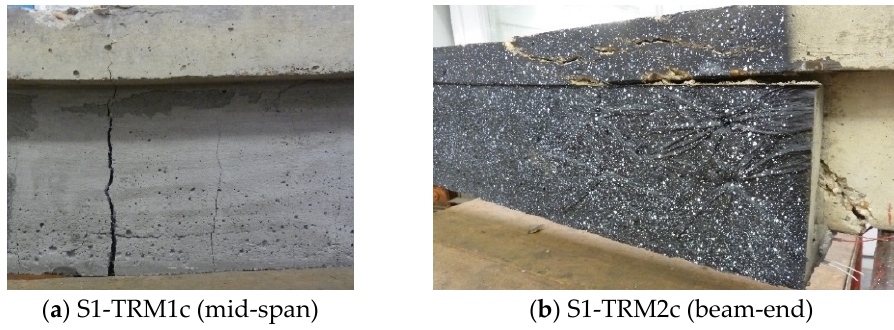
Figure 6. Observed failure in beams ( a ) S1-TRM1c and ( b ) S1-TRM2c. In series 2, with an increased a / d ratio, shear failure at the beam ends was observed for all three specimens, with shear cracking observed along the diagonal between the support and the load application (Figure 7). For specimen S2-FRP0, without FRP shear reinforcement, a strength increase of 7.5% was observed, but the failure mimicked that of the control specimen S2-C. In Figure 7b, a near-parallel shear crack originating from the end of the flexural FRP-reinforcement, caused by the end-peeling of the FRP, was also observed, with the angles of the two cracks (29 and 34 ◦ ) being close to that of the control specimen (32 ◦ ). In the specimen with continuous FRP shear strengthening (S2-FRP1c), the shear crack was found to be much steeper (39 ◦ ) than in the other two specimens, likely due to the FRP strengthening resisting crack formation in the diagonal between support and load application. Some debonding of the FRP U-jacket was also observed; however, it did not limit the capacity of the beam, for which a shear strength increase of +44.2% (28.7 kN) and an increase in initial stiffness of +25% were observed compared to the control specimen S2-C.